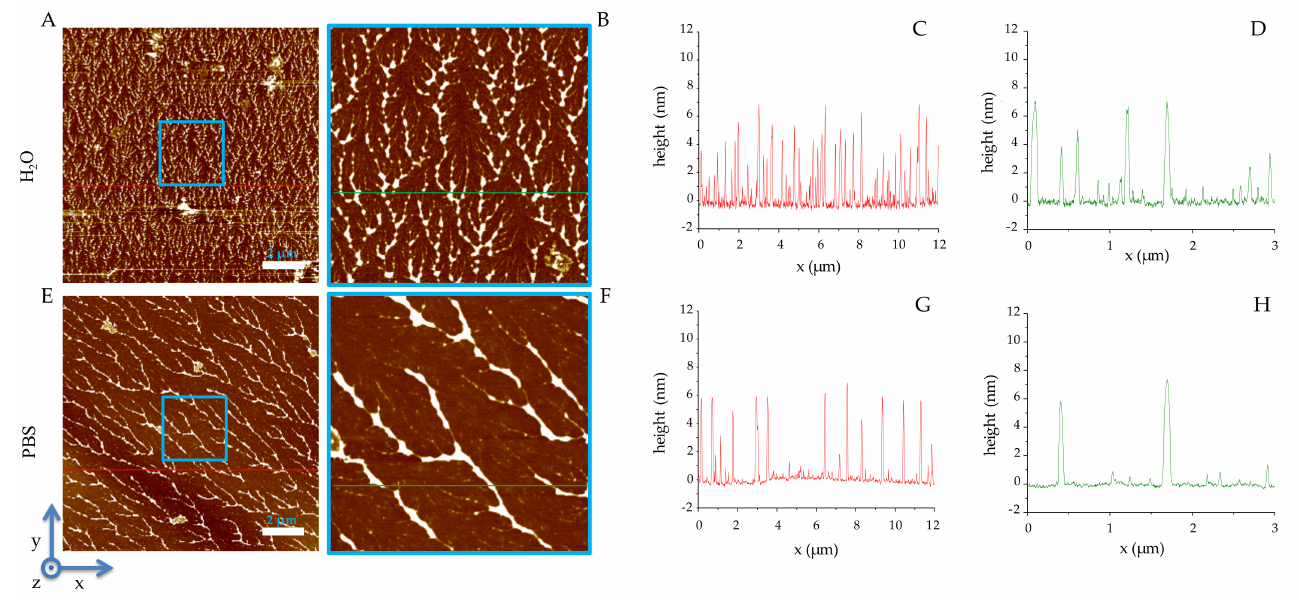
Figure 1. AFM images of RiLK1. ( A ) 12 µ m × 12 µ m field image of dried water solution of RiLK1, the scale bar is 2 µ m, the blue square locates the 3 µ m × 3 µ m field reported in image ( B ); heights referred to by the red line in ( A ) are reported in the graph line in ( C ) and the heights referred to by the green line in ( B ) are reported in the graph line in ( D ); ( E ) 12 µ m × 12 µ m field image of dried PBS solution of RiLK1, the scale bar is 2 µ m, the blue square locates the 3 µ m × 3 µ m field reported in image ( F ); heights referred to by the red line in ( E ) are reported in the graph line in ( G ) and heights referred to by the green line in ( F ) are reported in the graph line in ( H ).